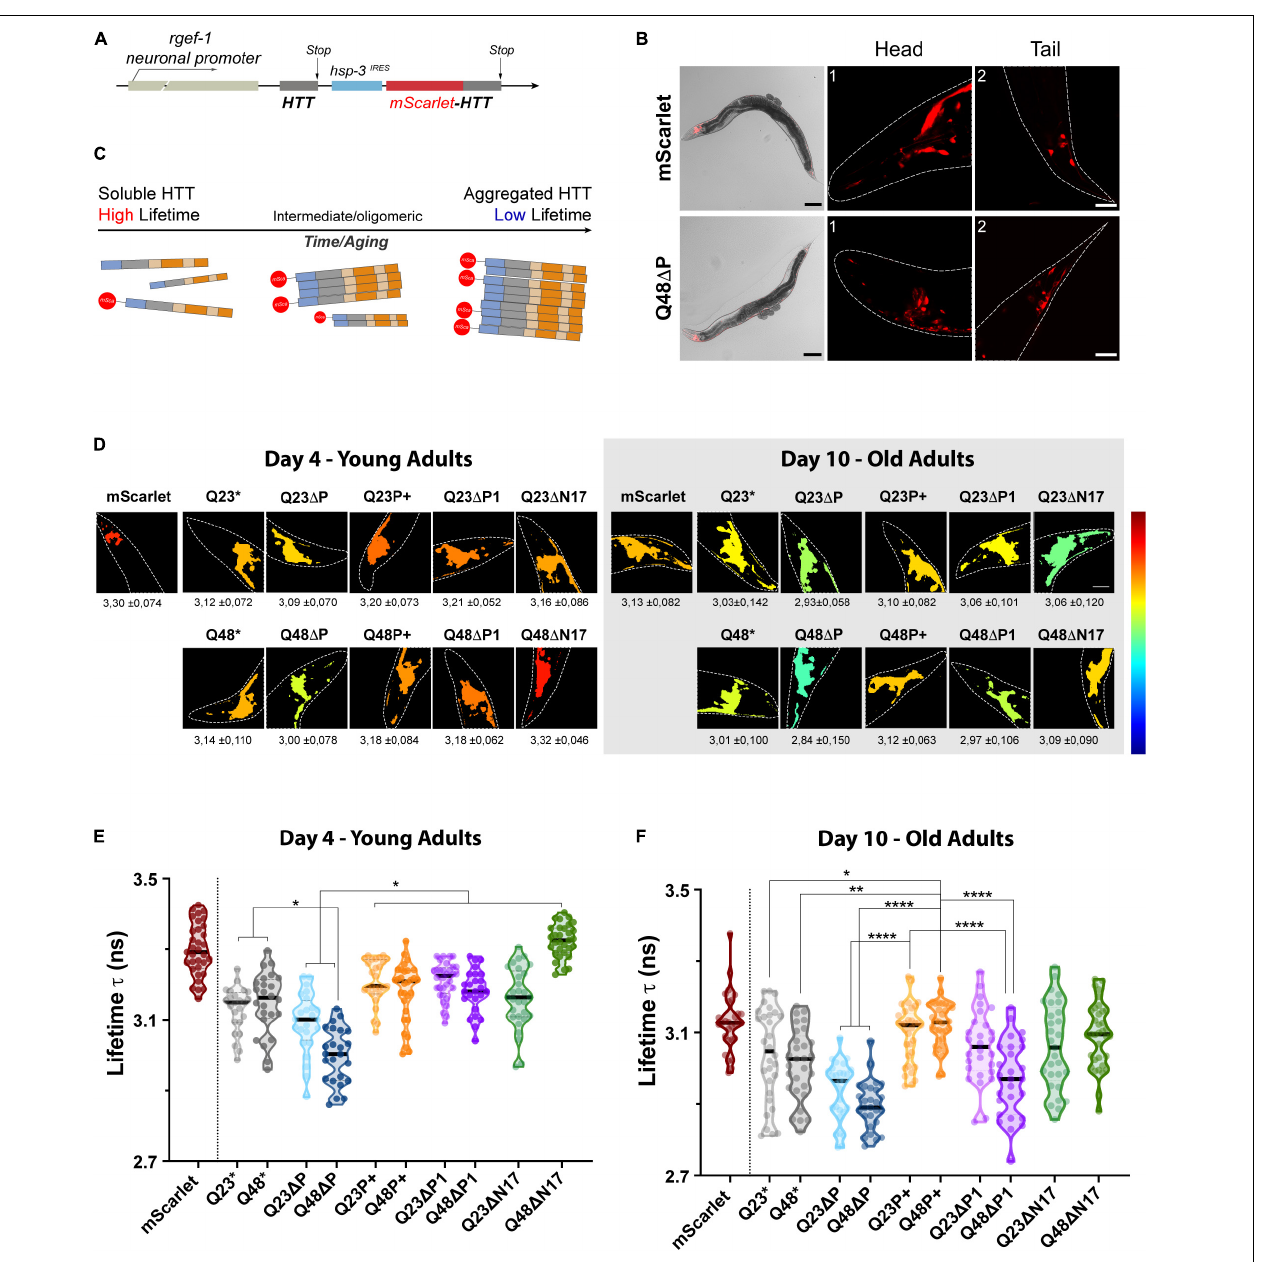
FIGURE 4 | The expanded proline domain maintains HTTEx1 soluble in vivo . (A) Schematic of the DNA construct used to generate the HTTEx1 C. elegans strains. A first moiety of HTTEx1 is transcribed under the control of a constitutively expressed neuronal promoter ( rgef-1) . A second HTTEx1 moiety fused to the mScarlet is transcribed under the control the hsp- 3 IRES . (B) Representative images of the fluorescent nematode strains. Top panels show the mScarlet control strain, while bottom panels show the Q48 (cid:49) P mutant. Whole nematode images, showing the transmission and mScarlet channels, are magnified 100x, scale bar 100 µ m; while head (1) and tail (2) neurons, corresponding to the squared highlighted regions, are magnified 630x times, scale bar is 20 µ m. (C) Graphical representation of the aggregation and consequent lifetime readout of the different constructs by FLIM analysis. Aggregated fractions contain both tagged and untagged HTTEx1 and will record a low fluorescence lifetime τ -value, while soluble moieties of tagged HTTEx1 will maintain a high fluorescence lifetime τ value. (D) TCPSC-FLIM pseudo-color images of representative nematode head neurons depicting the average lifetimes for each HTTEx1 C. elegans strain, at either day 4 (left) or day 10 (right). Average lifetime τ values ± SD (ns) are stated below each respective image. Dashed lines delimit the head region, magnified ≈ 1000 folds. High fluorescent lifetimes τ tend towards a red color, while low t tend towards blue, as referenced by the color scale on the left representing 2.3 to 3.5 ns. Lifetime calculations and images were generated with FLIMfit software (v. 5.1.1). (E,F) Truncated violin plots representing the average lifetimes recorded from the head neurons of nematode HTTEx1 strains, at day 4 (E) and day 10 (F) of life. Each circle represents an analyzed nematode. The median is shown by the single black thick line, while quartiles are delimited by above/below dotted lines. Three independent cohorts of at least 10 individual nematodes each were imaged. For statistical significance, a one-way ANOVA followed by Tukey post hoc test, assuming a confidence interval of 95%, was performed ( ∗ = p < 0.05; ∗∗ = p < 0.01 ; ∗∗∗∗ = p < 0.0001 ). For clarity, only selected significance is shown, for a full table of significance refer to Supplementary Table 2